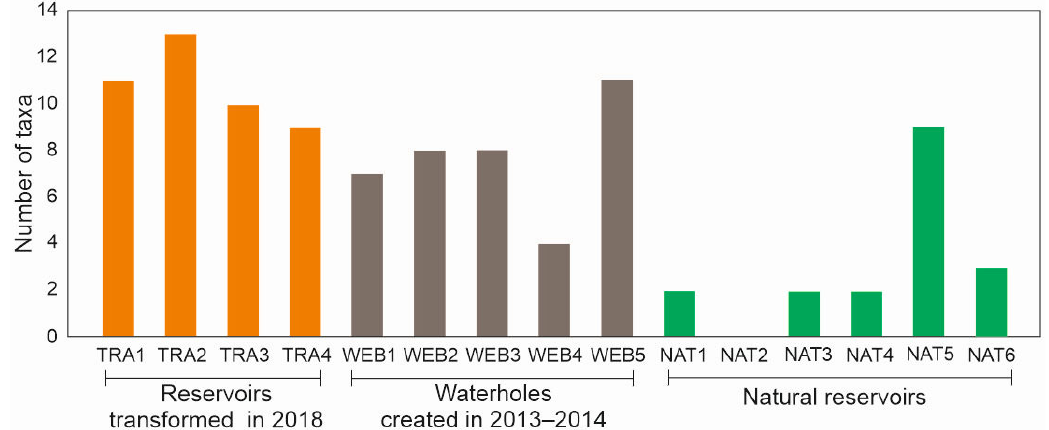
Figure 3. Number of dragonfly taxa found in the examined water reservoirs.